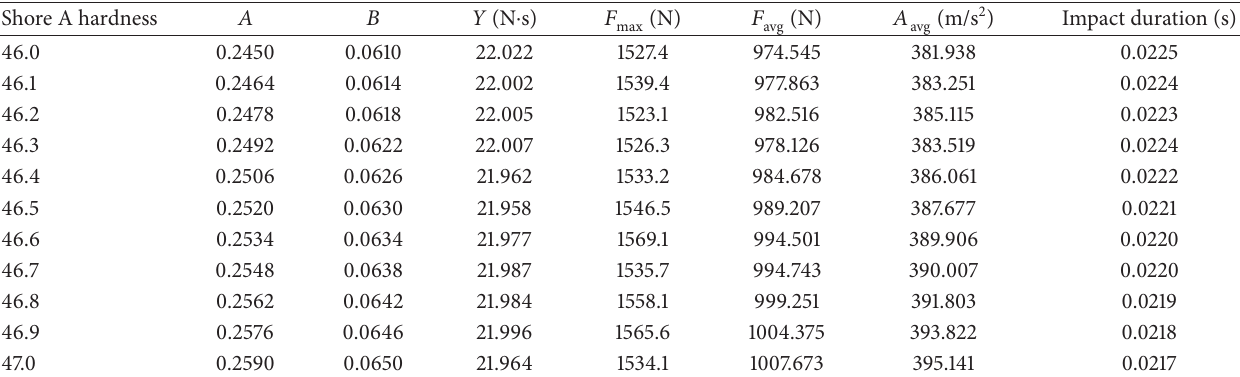
Table 5: Simulation results of rubber model for Shore A hardness from 46 to 47.